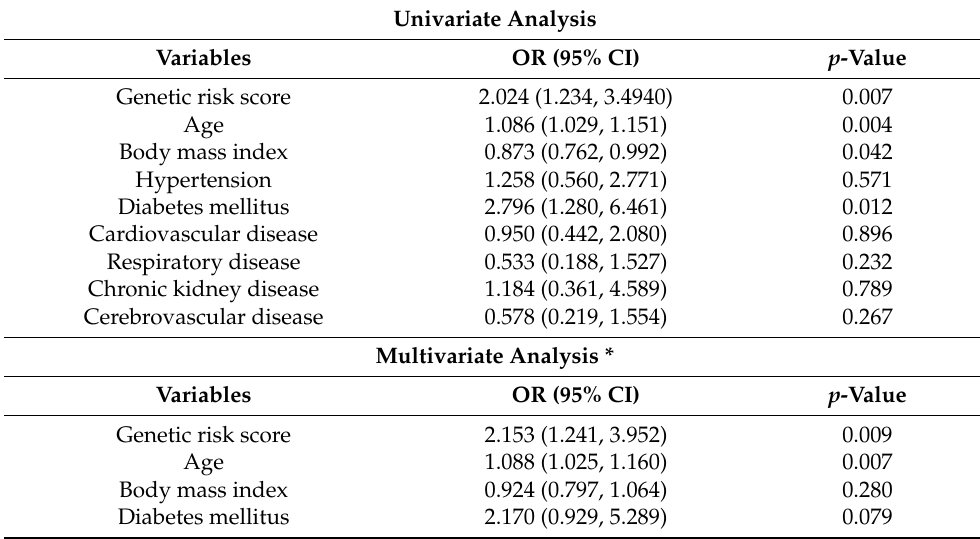
Table 6. Logistic regression analysis for PAD